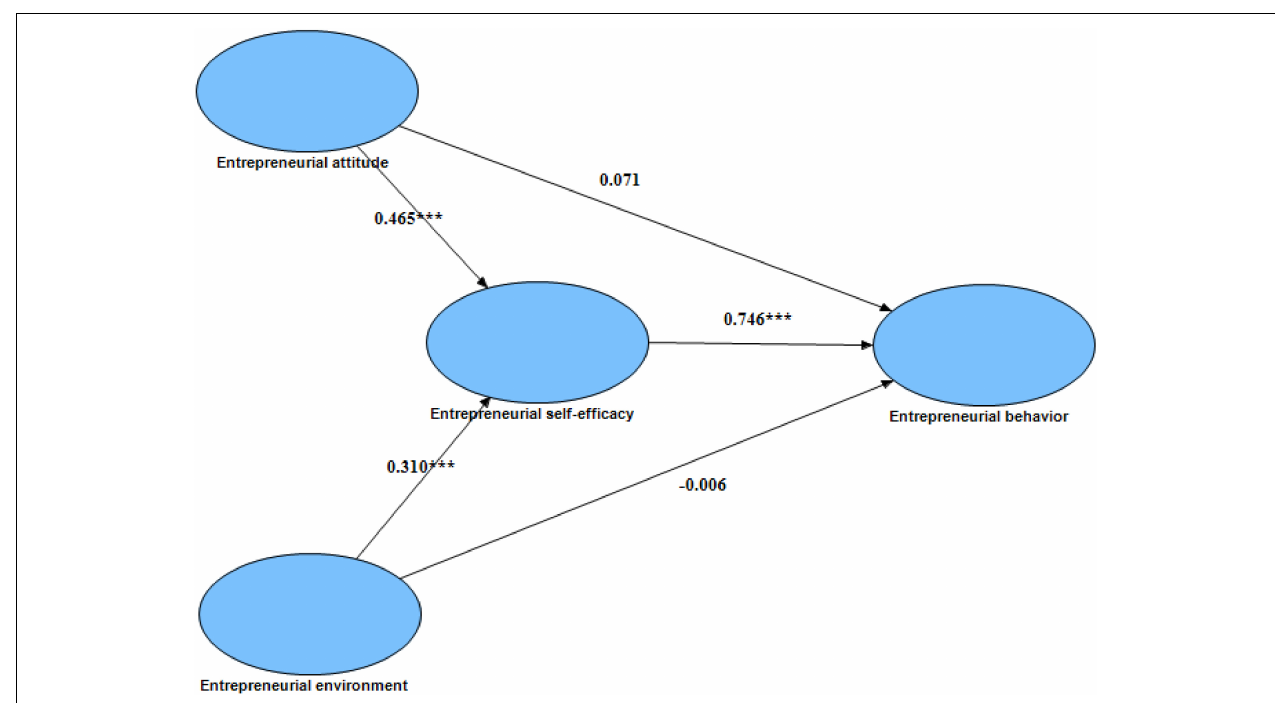
FIGURE 2 | Structural equation model path diagram. *** means significant at the 0.001 level.